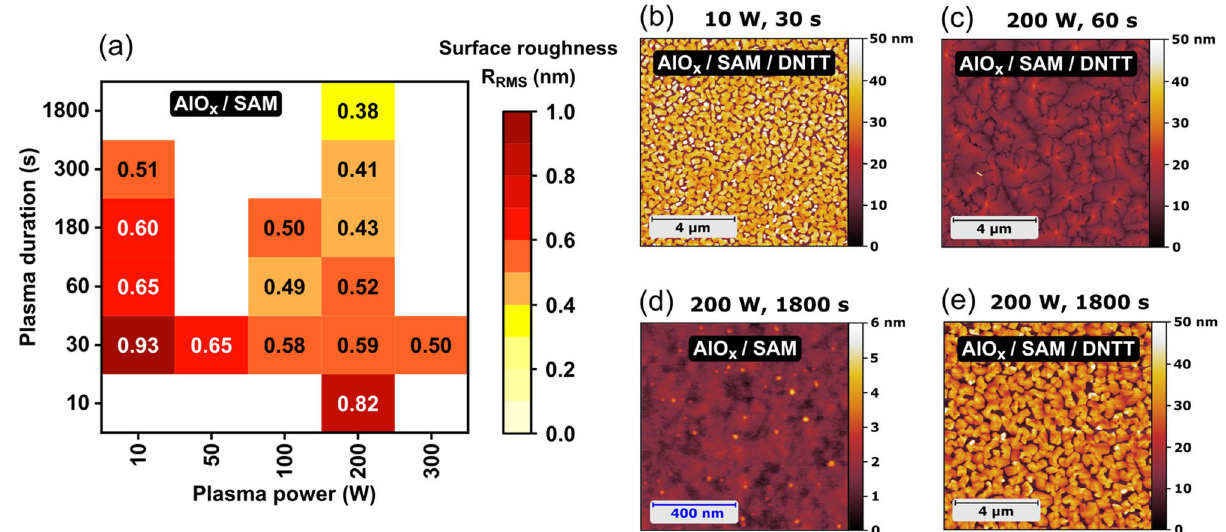
Figure 8. ( a ) Root-mean-square surface roughness of hybrid AlO x /SAM dielectrics as a function of plasma power and plasma duration. ( b – e ) AFM images of representative morphologies on the indicated surfaces with the indicated plasma